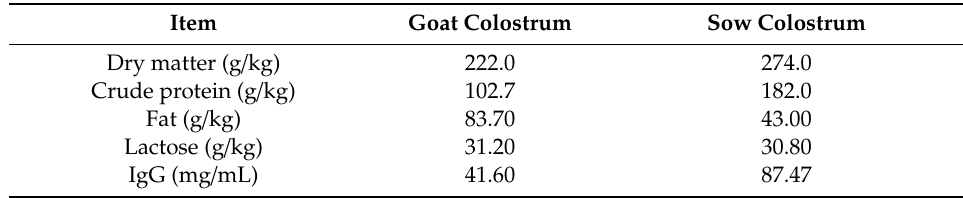
Table 1. Chemical composition and immunoglobin G (IgG) concentration of goat and sow colostrum fed to newborn piglets (as-fed basis). Goat